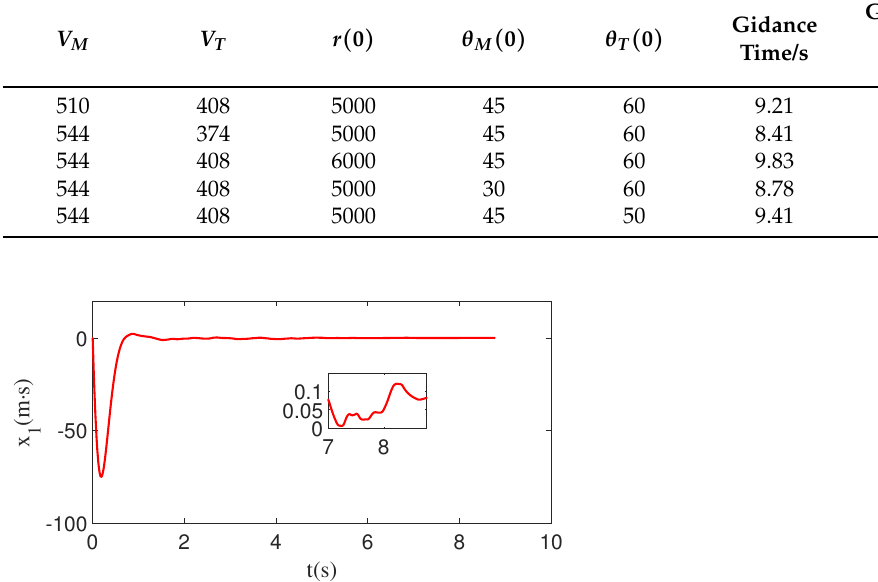
Table 4. Performances of different initial conditions with constant maneuver.